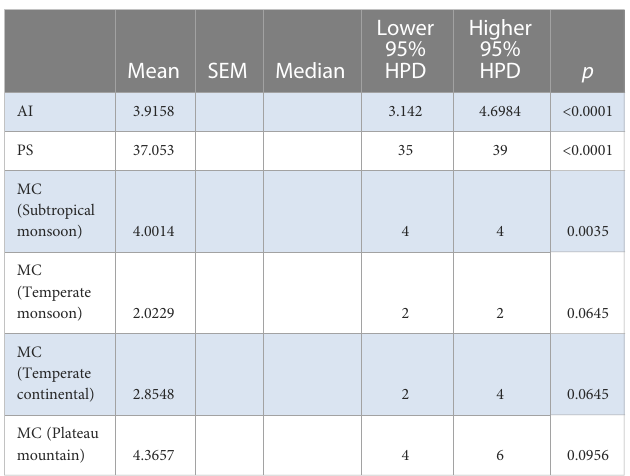
TABLE 6 BaTS algorithm analysis for the Chinese AMV population based on the bioclimatic